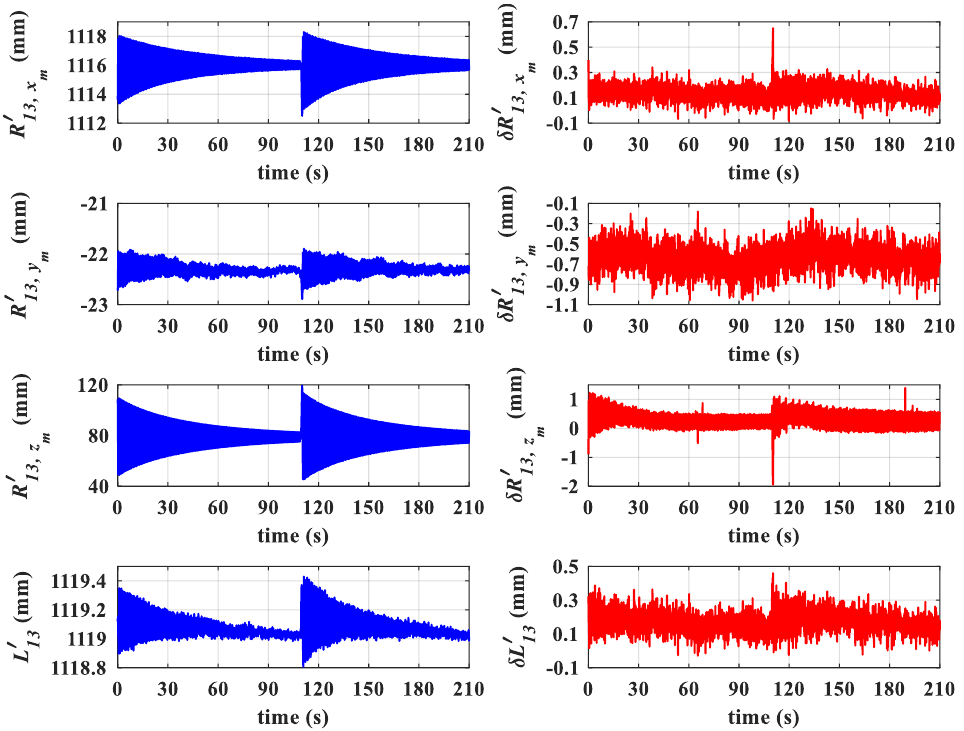
Figure 11. Measured values and errors of relative position and baseline length between antennas 1 and 3.